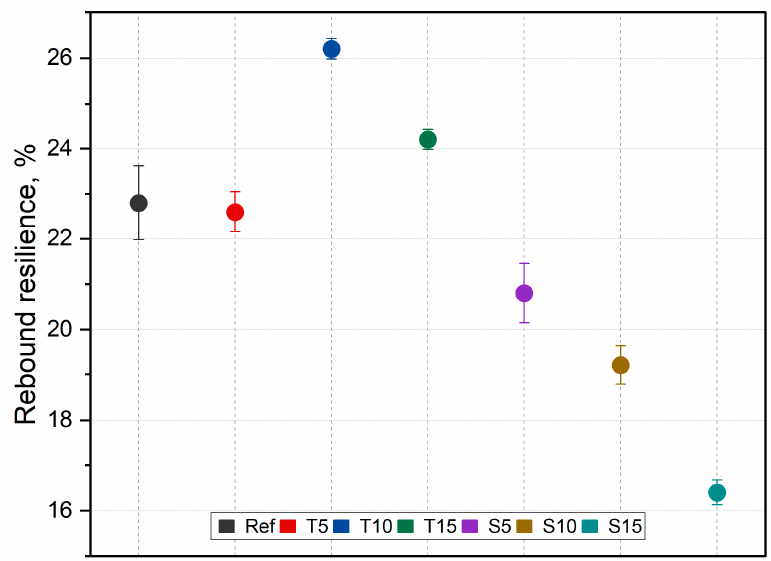
Figure 9. Rebound resilience results.